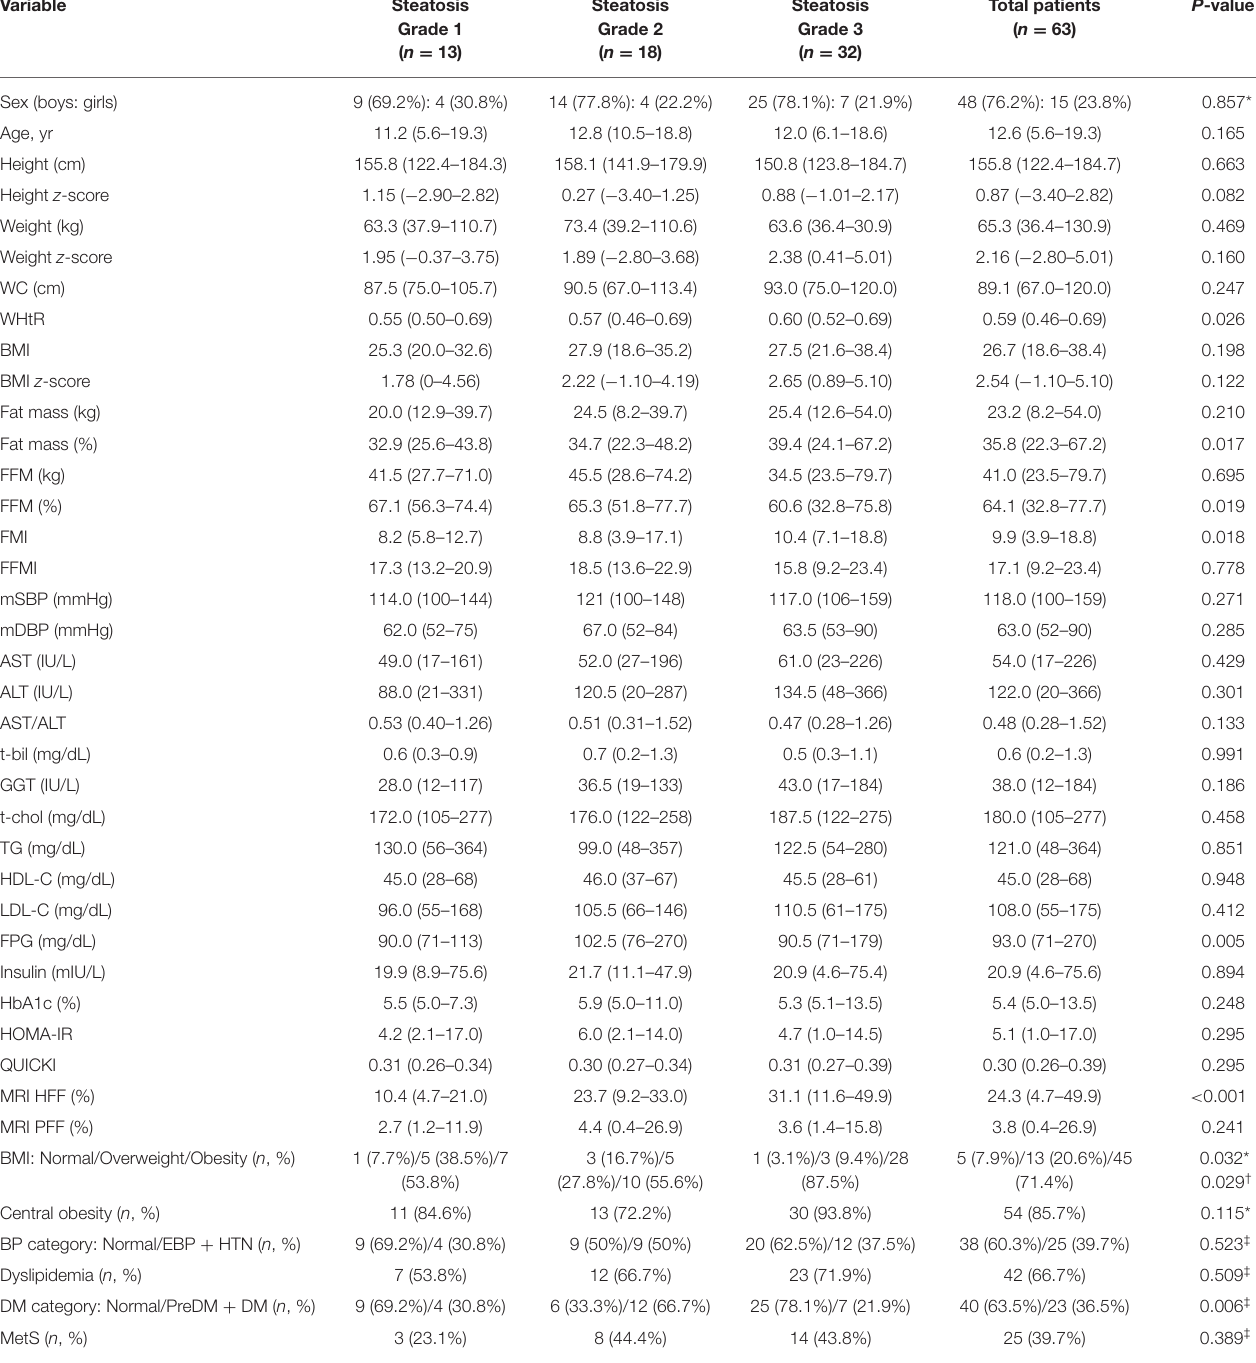
TABLE 2 | Comparison of demographic, anthropometric, laboratory, and magnetic resonance imaging-measured fat fraction findings of 63 children with non-alcoholic fatty liver disease according to liver histologic steatosis grade.